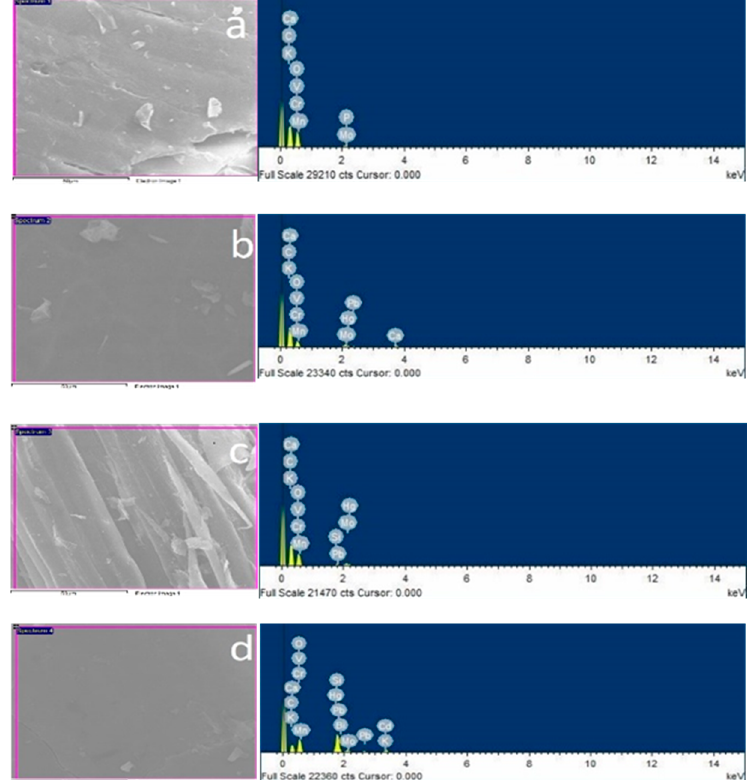
Figure 6. Scanning Electron Microscopy (SEM) / Energy Dispersive X-Ray (EDX) spectrum of all dung fibers and wheat straw: ( a ) IDF, ( b ) JDF, ( c ) BDF and ( d ) WS.